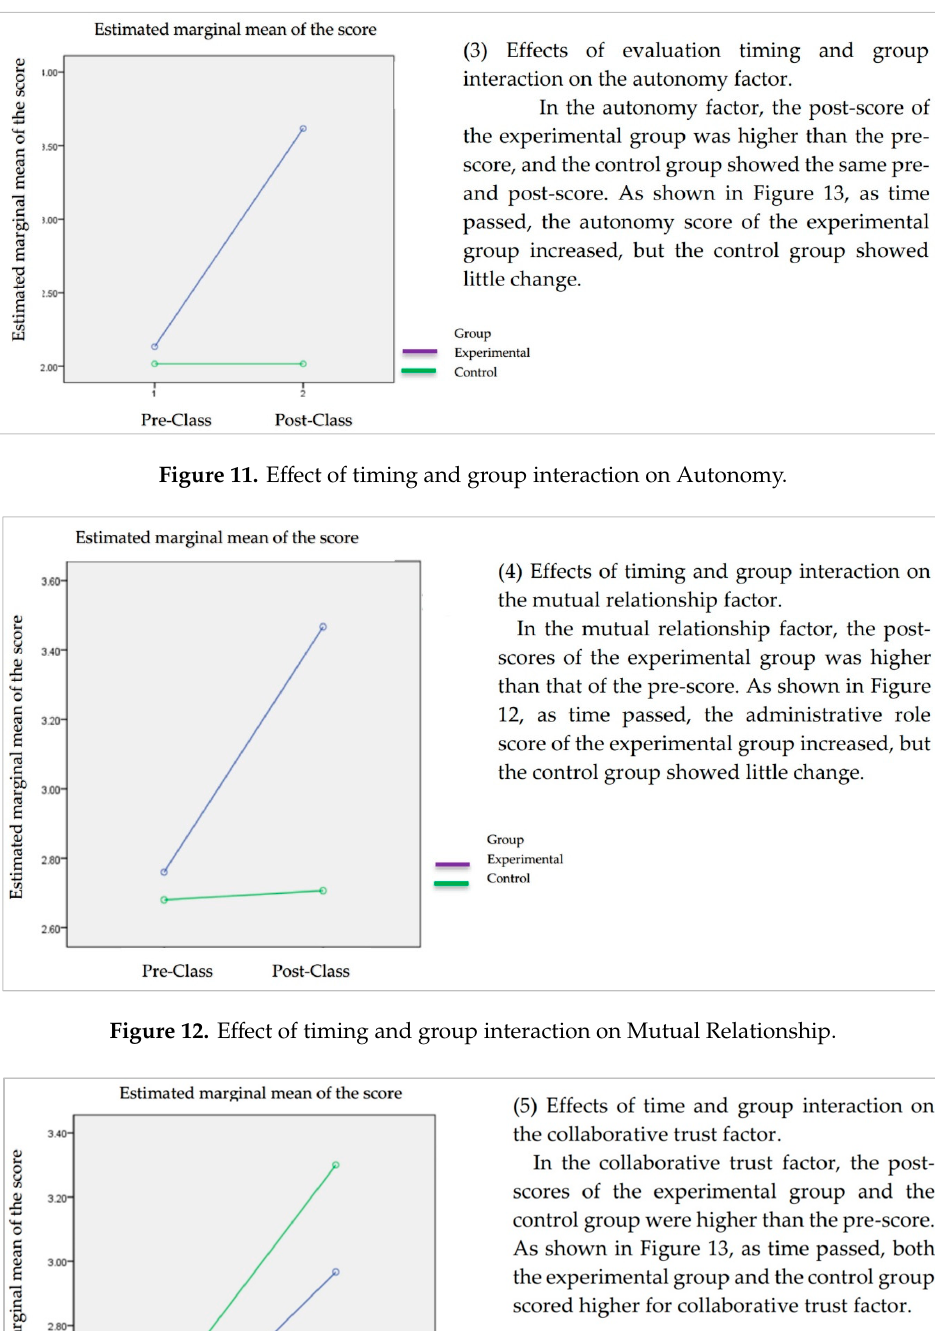
Figure 10. Effect of timing and group interaction on Administrative Role.